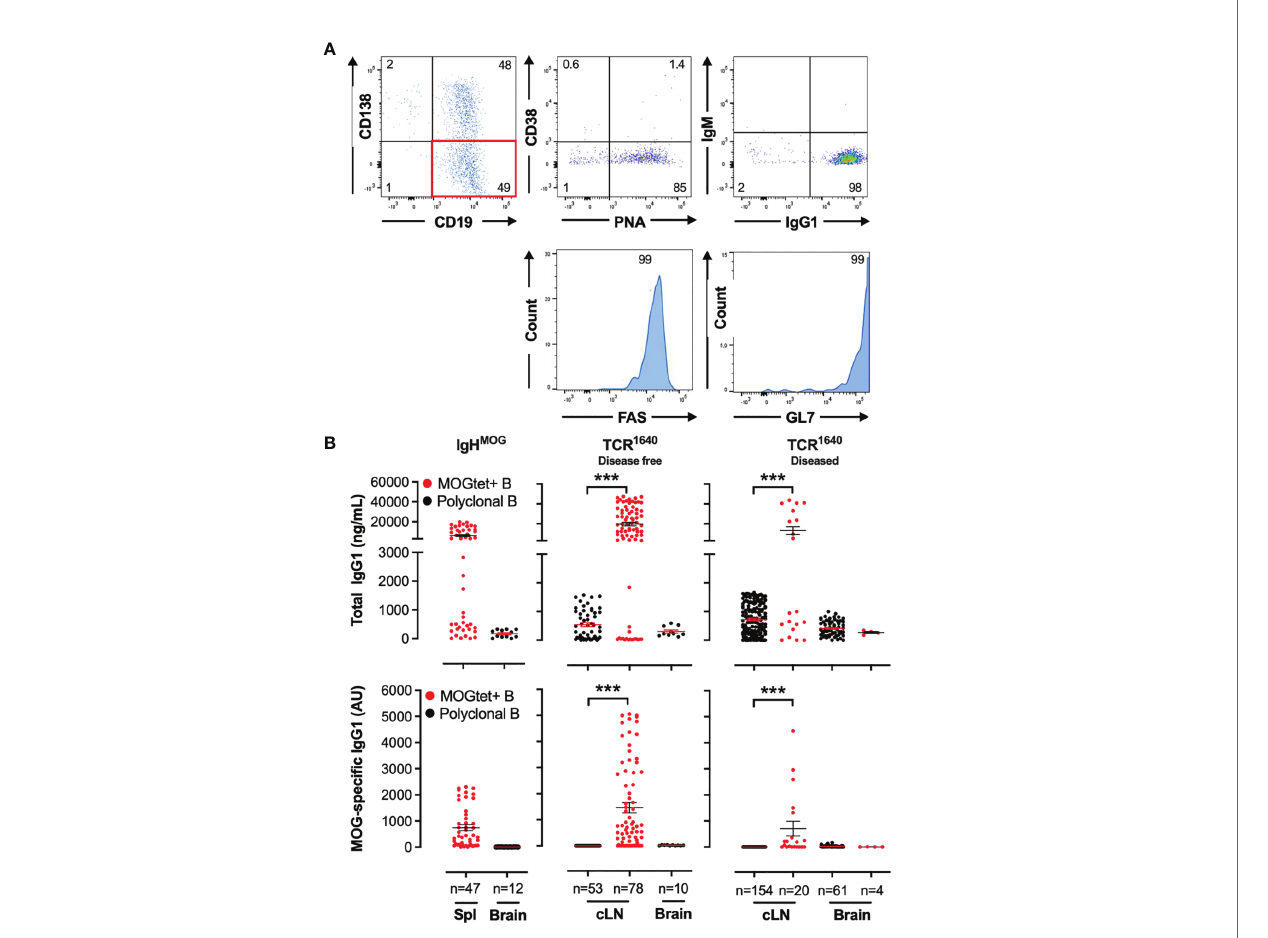
FIGURE 6 | Identi fi cation of MOG-speci fi c B cell clones by measuring total IgG1 and MOG-speci fi c IgG1 antibody titres in the supernatants from single-cell iGB cultures. (A) Differentiation of clonal B cells into CD138 + plasma cells and CD38 - GL7 + FAS + PNA + germinal centre B cells. iGB cultures of single B cells isolated from the cervical lymph nodes and brain of diseased TCR 1640 mice were analysed by fl ow cytometry after 8 days of culture. A representative pro fi le of viable CD19 + B cells demonstrate presence of CD138 plasma cells (Top row, left plot), and gated on CD19 + CD138 - B cells (Red quadrant) the expression of CD38 and PNA (top middle, intracellular IgG1 and IgM (top right), and histograms for FAS (bottom left) and GL7 (bottom right). (B) Total IgG1 (top row) and anti-MOG IgG1 (bottom row) antibodies were detected in supernatants from spleen, cervical lymph nodes, and brain-derived single B cell iGB cultures from IgH MOG (Left column), disease-free TCR 1640 (middle column) and diseased TCR 1640 mice (right column). Clonal B cells were isolated from the polyclonal CD19 + B cell compartment (black circles) or from the CD19 + MOG + test B cell response (red circles). The individual antibody concentration of n clonal iGB cultures is presented together with the Mean +/- SEM. Data represents the pooled results of 3 independent experiments and was analysed with a t-test. ***p <